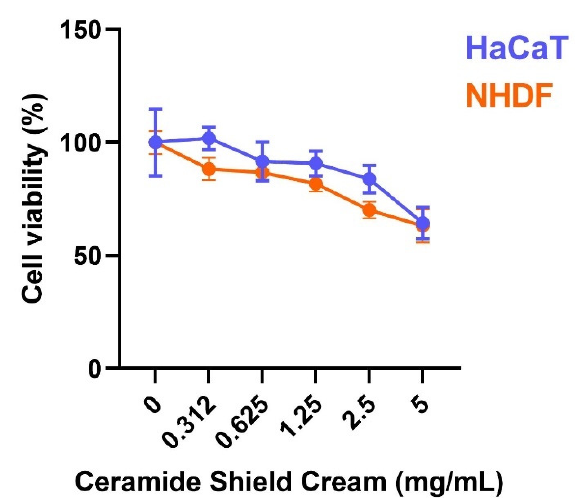
Figure 1. Cell viability (%) of HaCaT cells (in blue) and NHDF cells (in orange) after treatment with different concentrations of the cream (range between 0.312 and 5 mg/mL) with respect to untreated cells ( n = 2; replicates = 3).